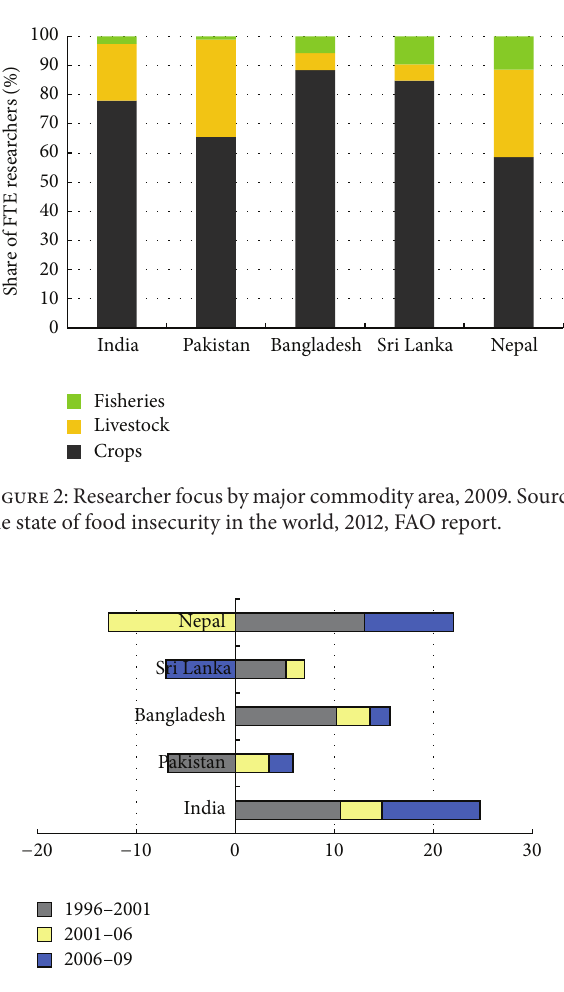
Figure 3: Annual growth in public agricultural R&D spending (%). Source: the state of food insecurity in the world, 2012, FAO